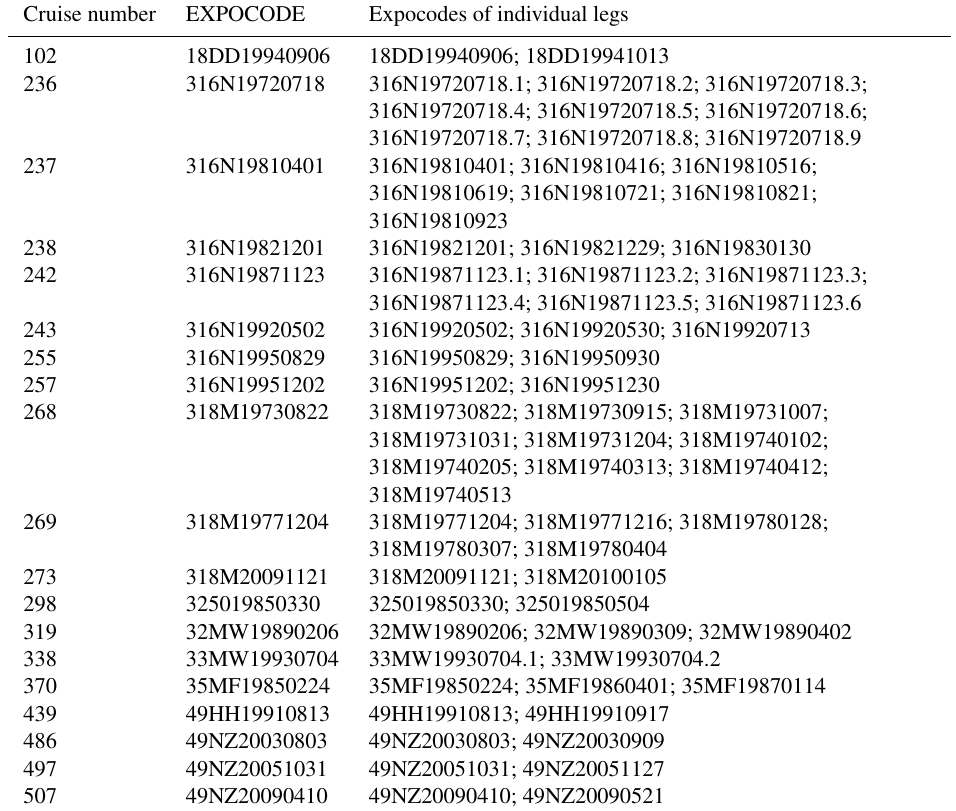
Table 4. Multi-leg cruises in GLODAPv2 that received secondary quality control on a per-leg basis but are included as a single cruise in the product files.